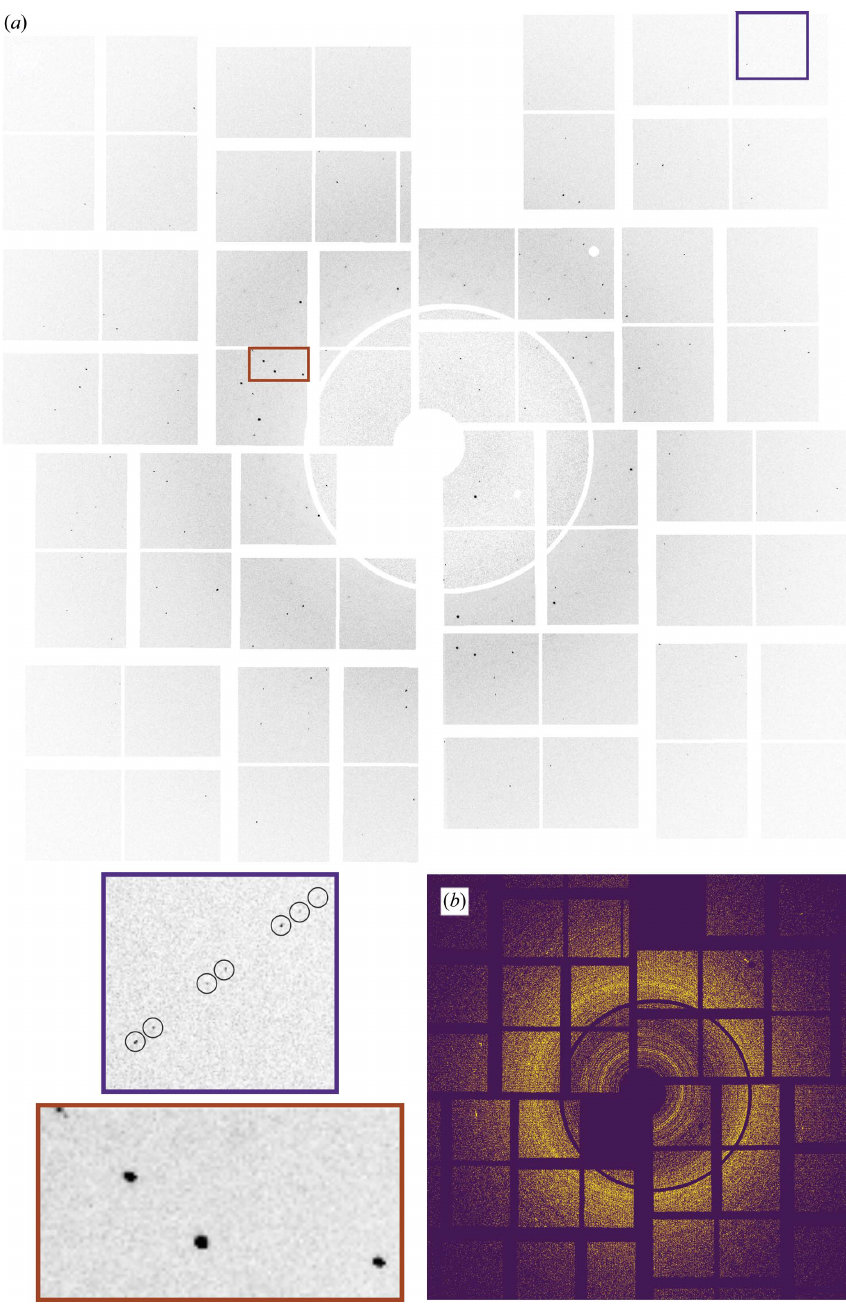
Figure 3 ( a ) An individual diffraction pattern of an intracellular HEX-1 crystal in a Sf9 cell, recorded at room temperature on a Roadrunner II chip with a CSPAD detector. The maximum resolution was limited by the setup to 2.0 A˚ at the detector edges. Higher resolution peaks of up to 1.70 A˚ could be detected in the detector corners (blue inset). The shape of the peaks indicates low mosaicity (red inset). ( b ) Virtual powder diffraction pattern of HEX-1 crystals recorded in cellulo shows a homogeneous distribution of crystal orientations. The sum of detected Bragg peaks detected by indexamajig from the CrystFEL suite in all images resulting from the data collection from chips 1 and 2 is